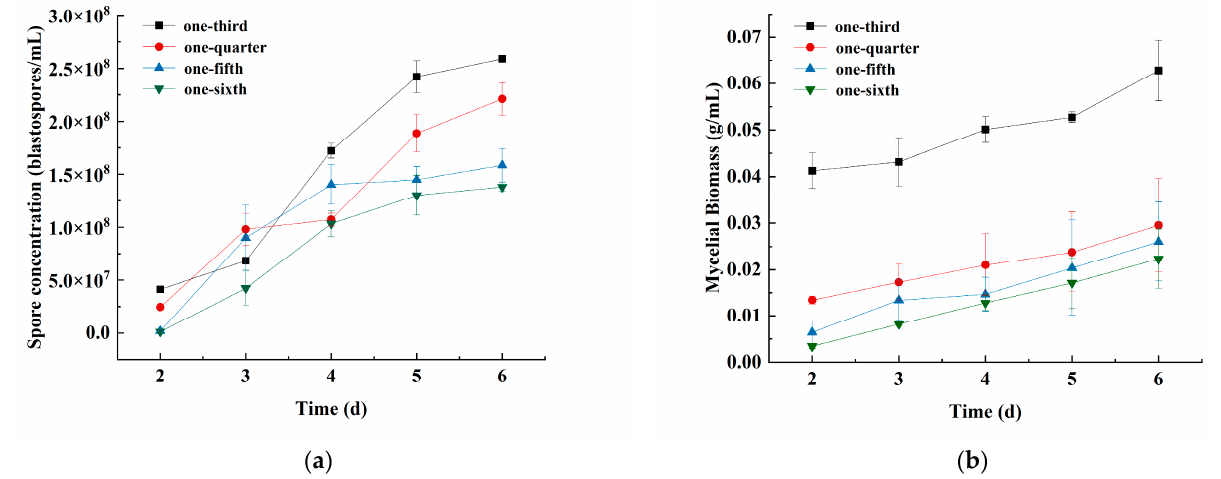
Figure 4. Effects of different medium-to-flask ratio on the ( a ) spore concentration and ( b ) mycelial biomass of strain JMF-01. The data in the figure are the mean ± SEM. The SEM of three repetitions is shown in bars.